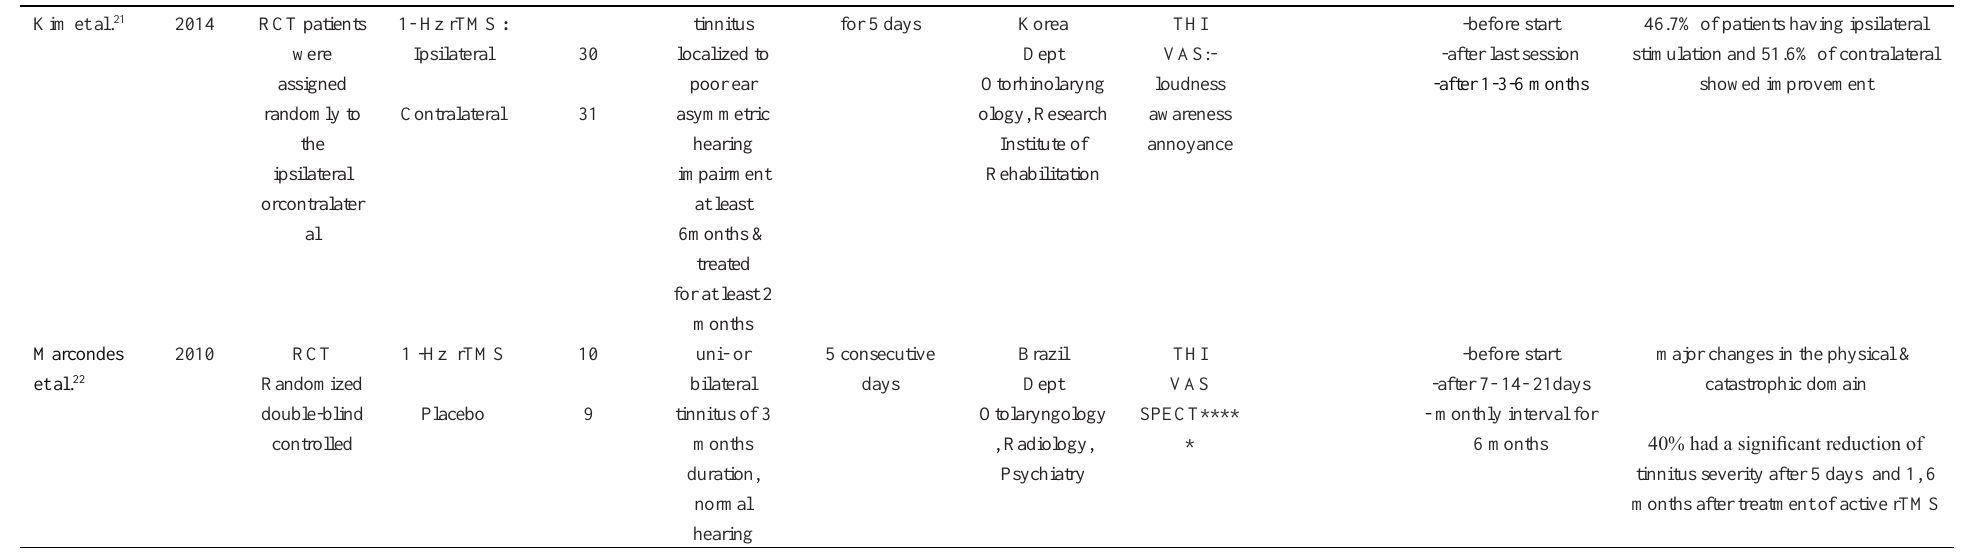
Table 1. Patients with tinnitus with rTMS intervention for randomized controlled studies (RCT) with at least 6 months of